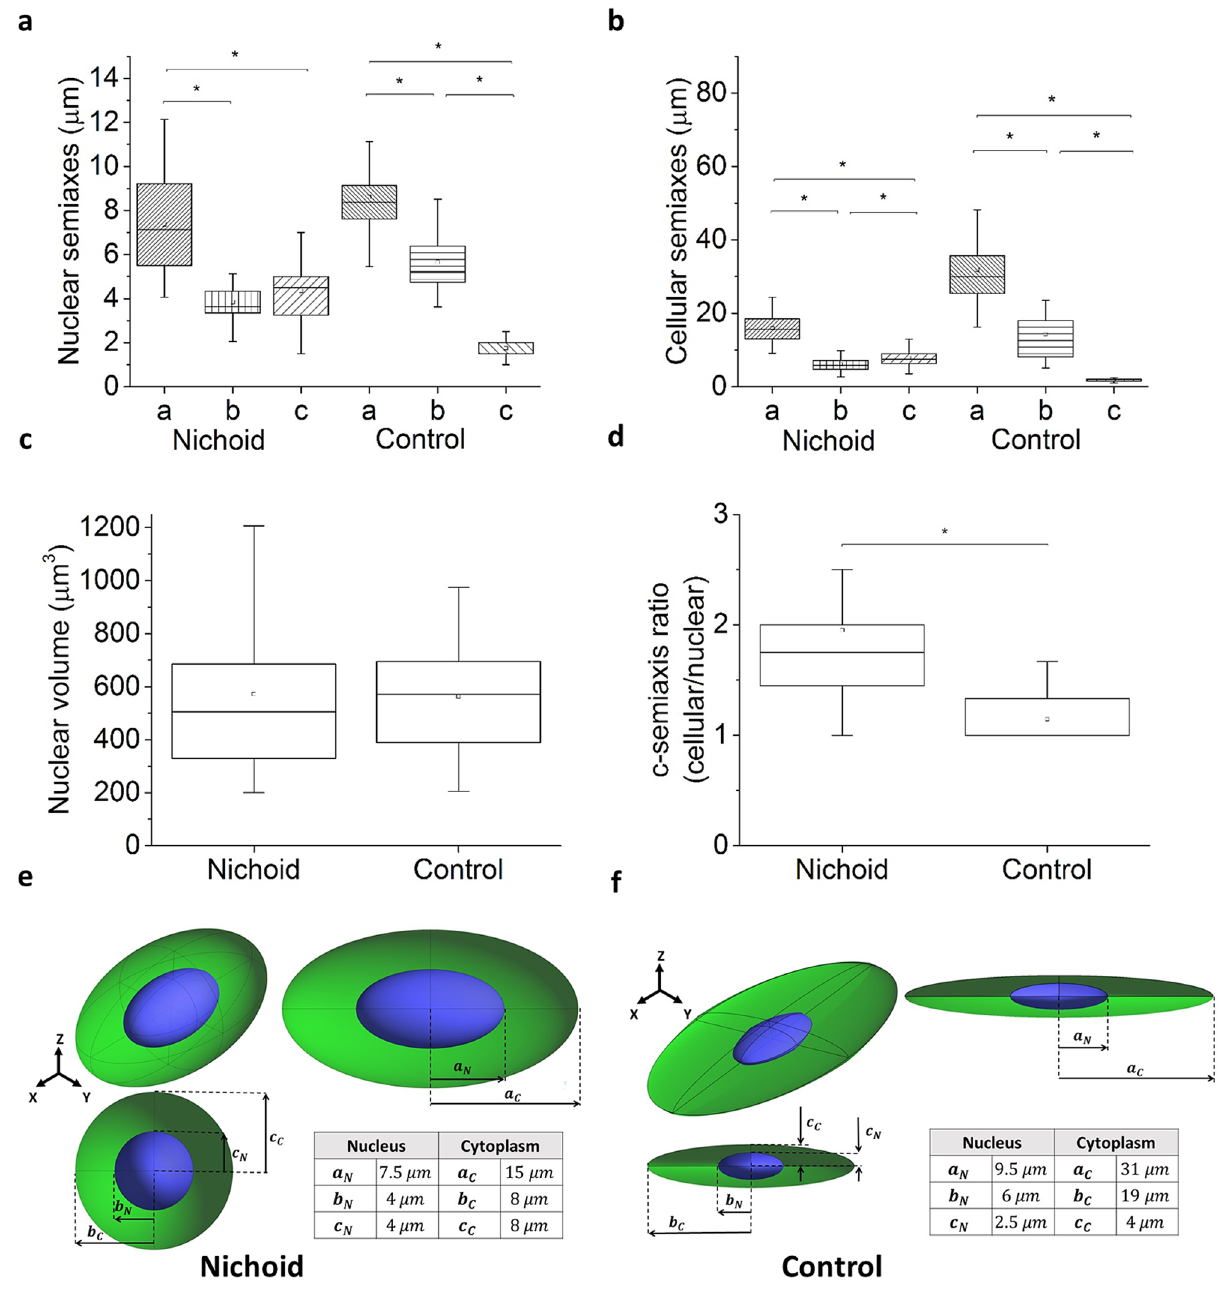
Figure 4. Spatial organization of cell morphology within the Nichoid artificial niche. ( a ) Nuclear semiaxes length calculated by fitting the xy, xz projection of the nuclei with an ellipse. The lengths show that the nucleus of MSCs grown into the Nichoid is modeled with a prolate ellipsoid and that the cells grown on the Control are scalene ellipsoid. ( b ) Cellular semiaxes length calculated inscribing the cell with an ellipsoid. The graph shows that the Control cells are very thin and elongate. ( c ) Nuclear volume calculates as sum of the image’s voxel. ( d ) Ratio of the cell semiaxis length divided by the nuclear semiaxis length. The graph shows that on the control the cell and the nuclear thickness are equal. ( e, f ) 3D reconstruction of nuclei (blue) of MSCs grown in the 3D-Nichoid and on the 2D-Control and semi-axes data used for the computational modelling. The software used to create the images is Ansys 2019 R2 (www.ansys .com). Graphs ( a ) and ( b) statistics: Kruskal–Wallis multicomparison test. Graphs c and d statistics: Mann–Whitney test. *Corresponds to p <